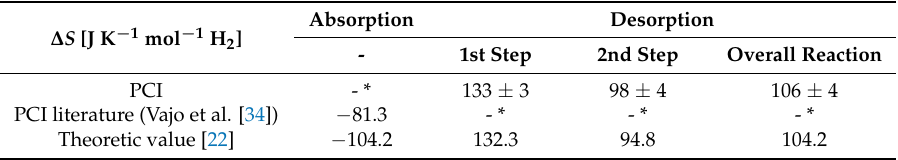
Table 3. Comparison of the entropy ∆ S values of the Li-RHC system by different